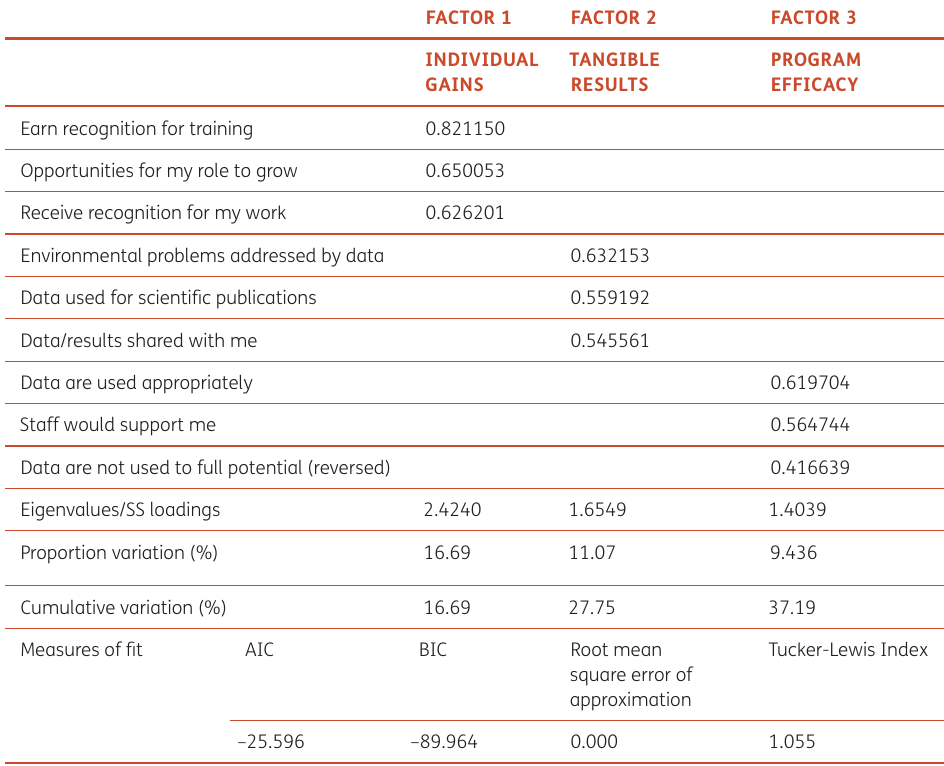
Table 5 Organizational variable factor loadings, eigenvalues, variation, and measures of fit. AIC = Akaike information criterion; BIC = Bayesian information